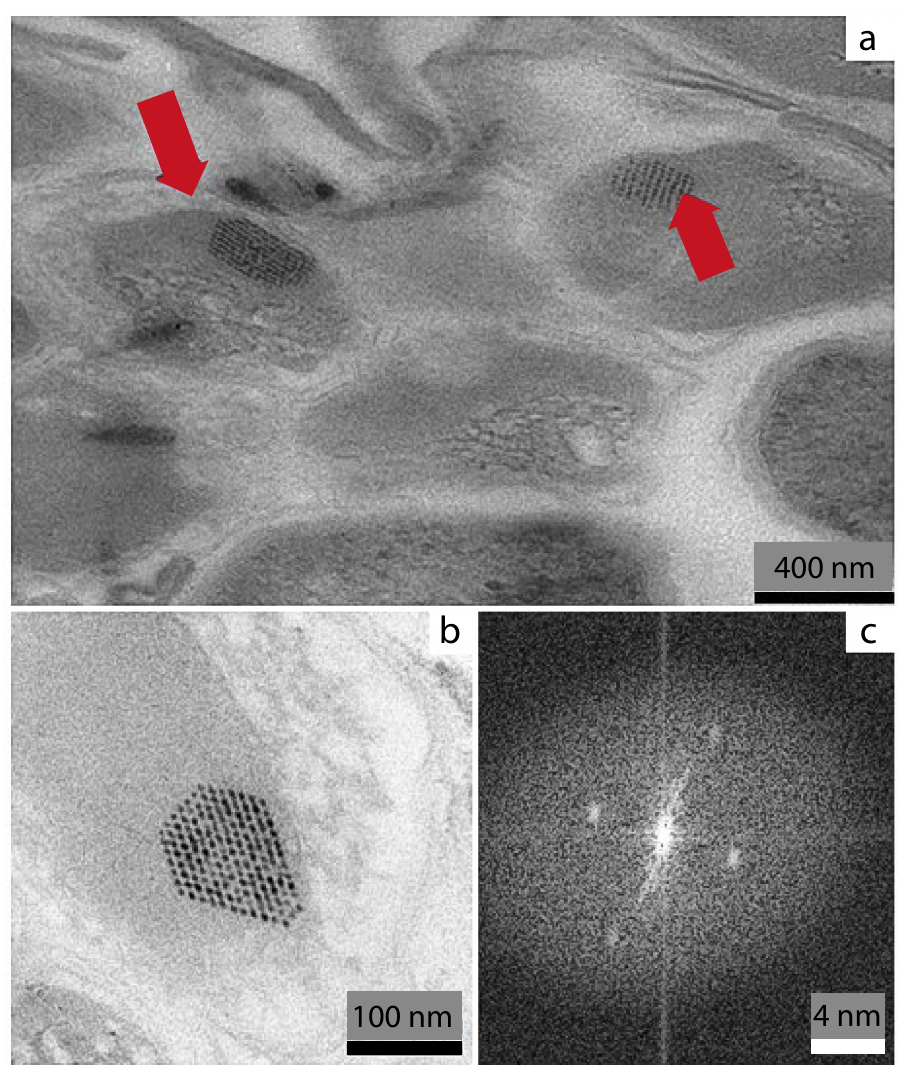
Fig. 2 Transmission electron photomicrographs (magni fi cation 71,000×) showing the highly symmetrical bacterial microcompartments (BMCs)/ carboxysome-like structures. a Red arrows indicate carboxysome-like structures in the cellular cytoplasm of Carbonactinospora thermoautotrophica StC; b a close view of a carboxysome- like structure; and c The Fast Fourier Transform (FFT) image of the carboxysome-like structure, which is a mathematical representation of the spatial frequencies of the image 25 , showing that the StC carboxysome-like structure has a periodic organization with a well-ordered and highly symmetrical